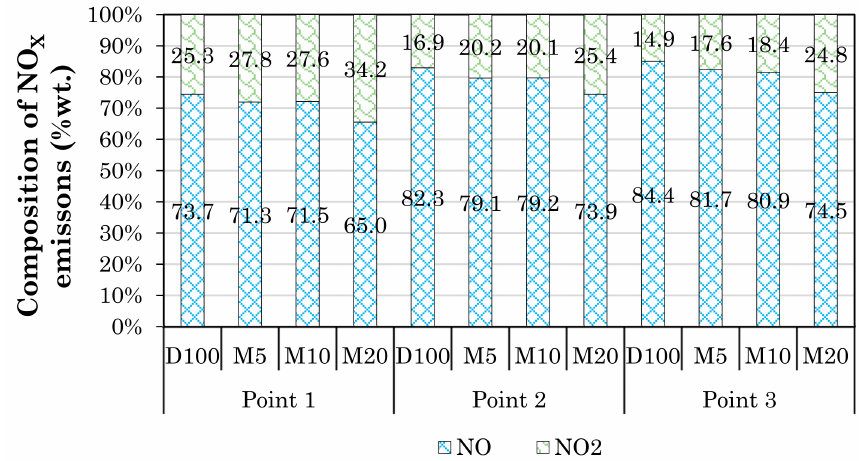
Figure 12. Constituents of NO X emissions for all test fuels at all measurement points.